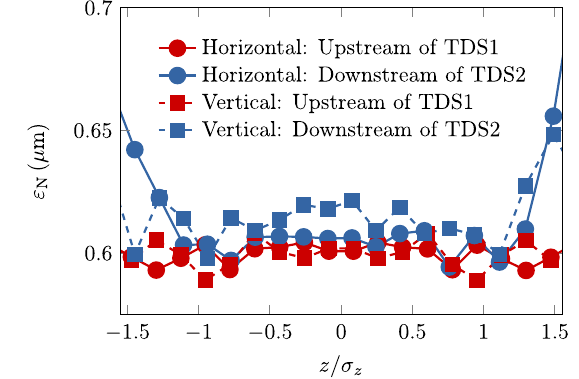
FIG. 6. Simulation of the normalized slice emittance for both the vertical and horizontal upstream of the first and downstream of the second TDS. CSR effects are